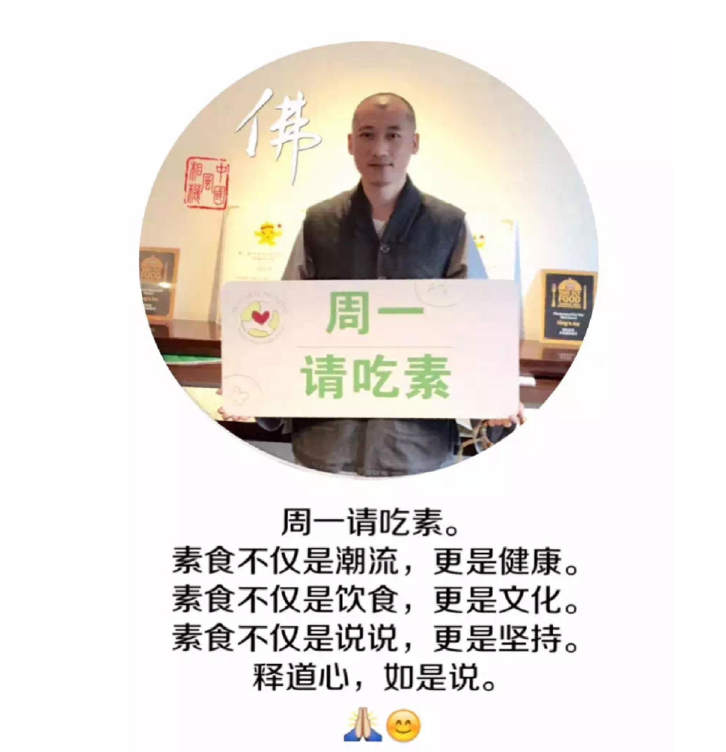
Image 5: Daoxin’s Wechat Moment: On Monday Eat Vegetarian